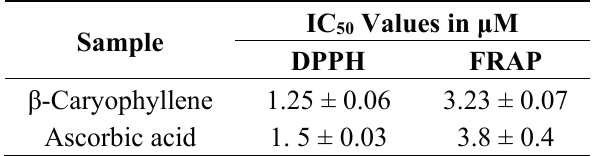
Table 1. Antioxidant efficacy of β